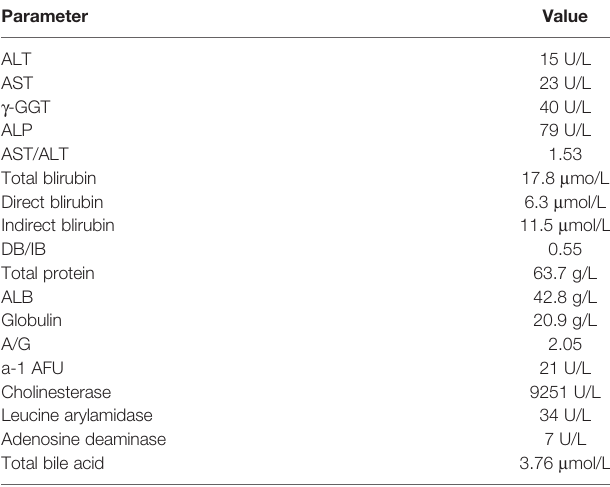
TABLE 1 | Biochemical laboratory values in April